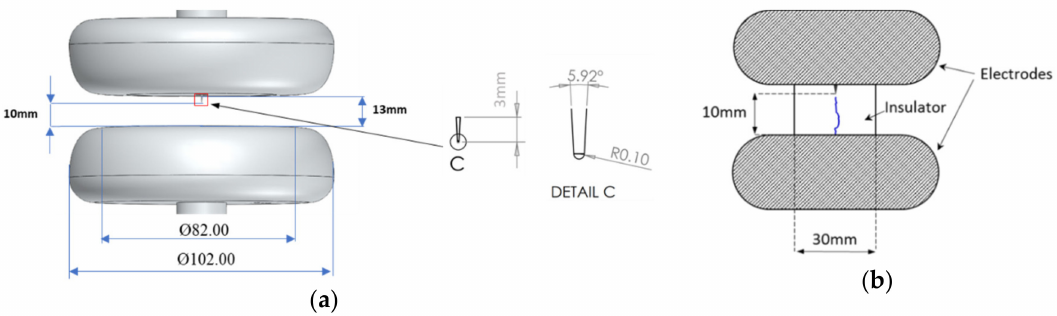
Figure 2. Electrode configuration: ( a ) Needle to a plane arrangement for breakdown investigations; ( b ) Insulator model for surface flashover experiments.